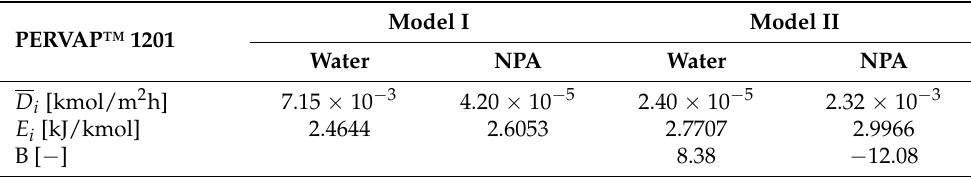
Table 2. D i , E i , and B values of n-propanol–water binary mixture estimated by STATISTICA ® program environment.